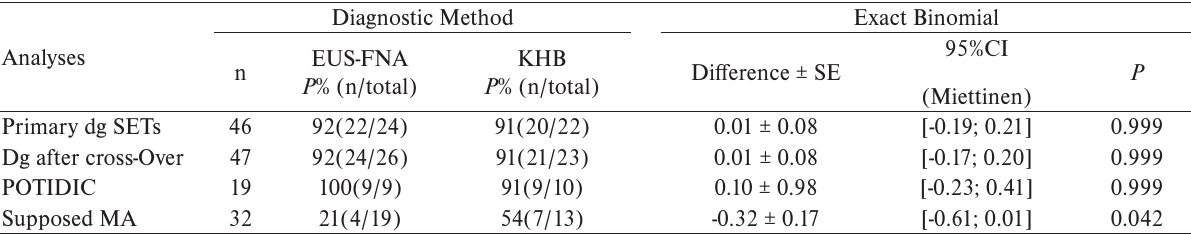
Table 4. Comparison of EUS-FNA and KHB in preoperative and postoperative diagnostics of upper gastrointestinal SETs (EUS-FNA vs KHB).